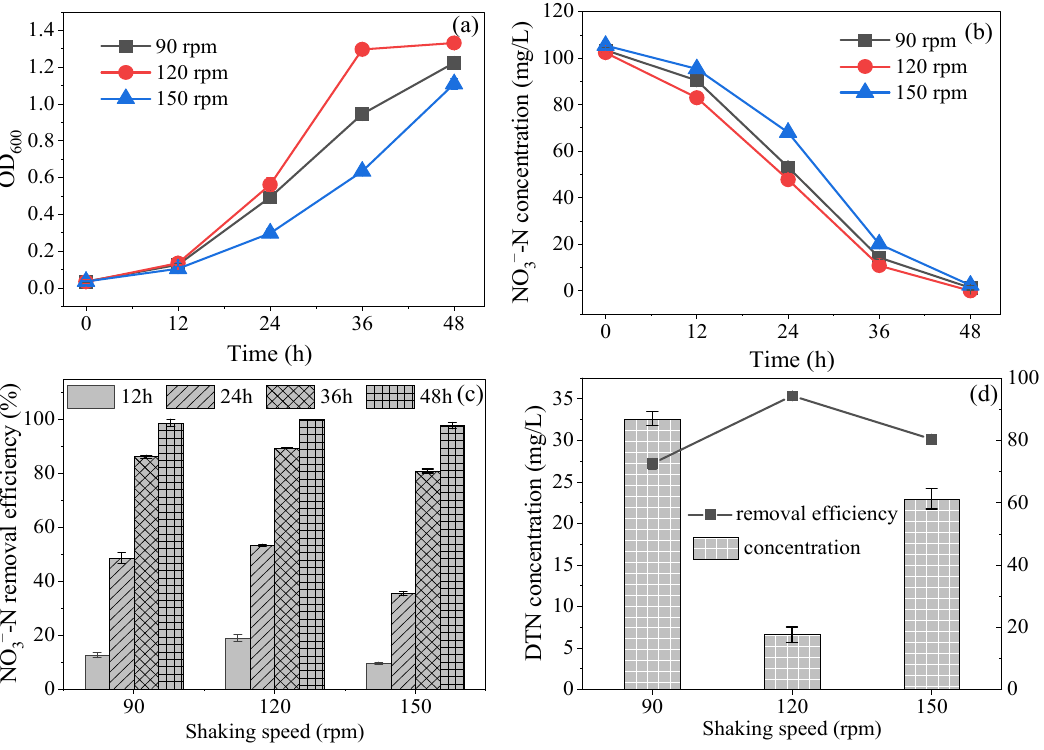
Figure 8. Effect of DO on nitrogen removal performance of strain 41. ( a ) Growth curves of strain 41; ( b ) variation of NO 3 − -N concentration; ( c ) removal efficiency of NO 3 − -N; ( d ) removal characteristics of DTN.